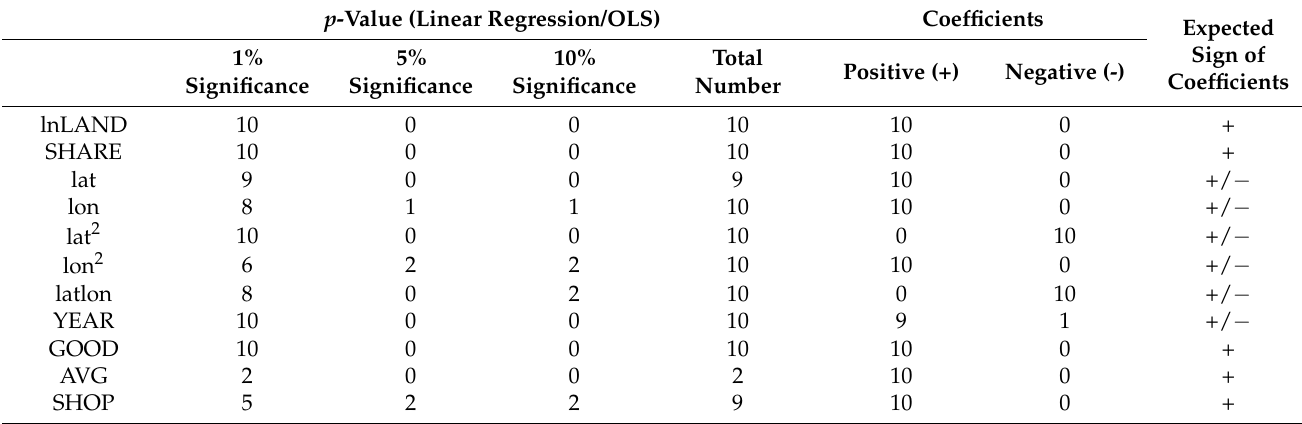
Table 3. Statistical Analysis of PIHPI_HR Model (2009–2019). p -Value (Linear